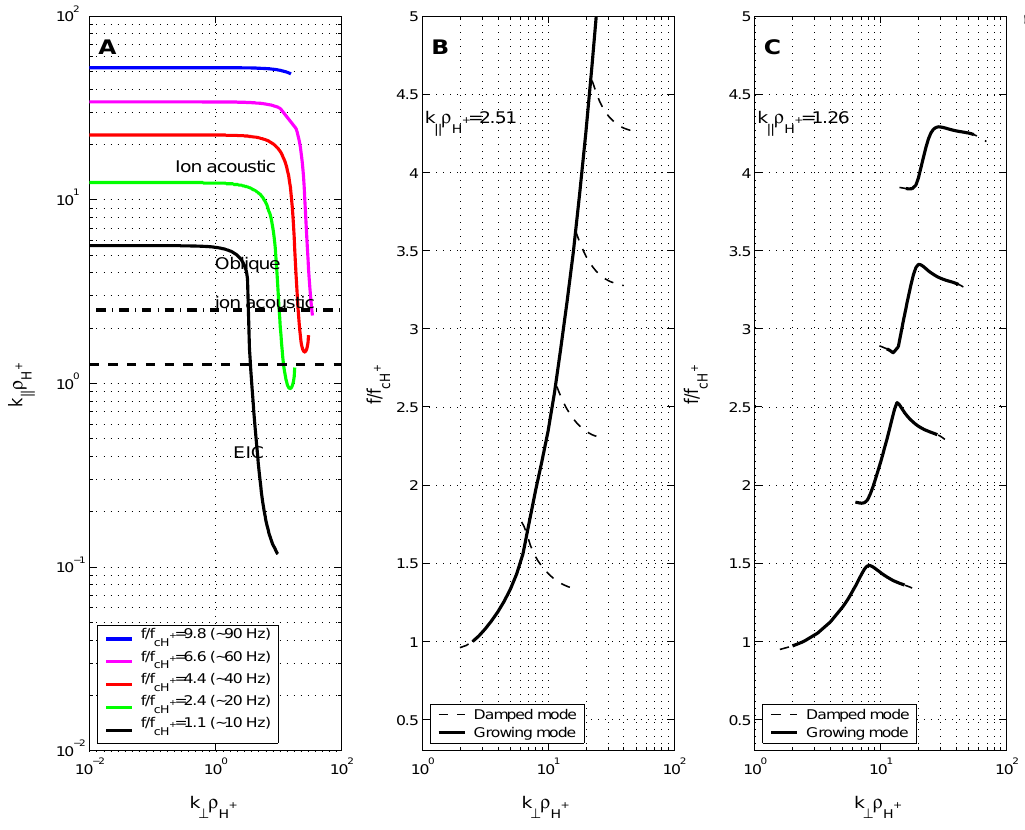
Fig. 9. The solution to the dispersion relation (A) . Contours of constant frequency are plotted versus normalized parallel and perpendicular wave vectors. Here ρ H + = 16km is the gyro radius of the 4.5keV protons in the plasma model. We identify the wave located on different parts of the dispersion surface as ion acoustic, oblique ion acoustic and Electron Ion Cyclotron (EIC) waves. The two horizontal lines indicate the location of the cross sections in panels (B) and (C). The oblique ion acoustic mode is continuous in frequency as is seen by a cross section at k k ρ H + = 2 . 51 (B) . At smaller parallel wave vectors the dispersion surface is fragmented and consists of ridges associated with the H + harmonics (C)